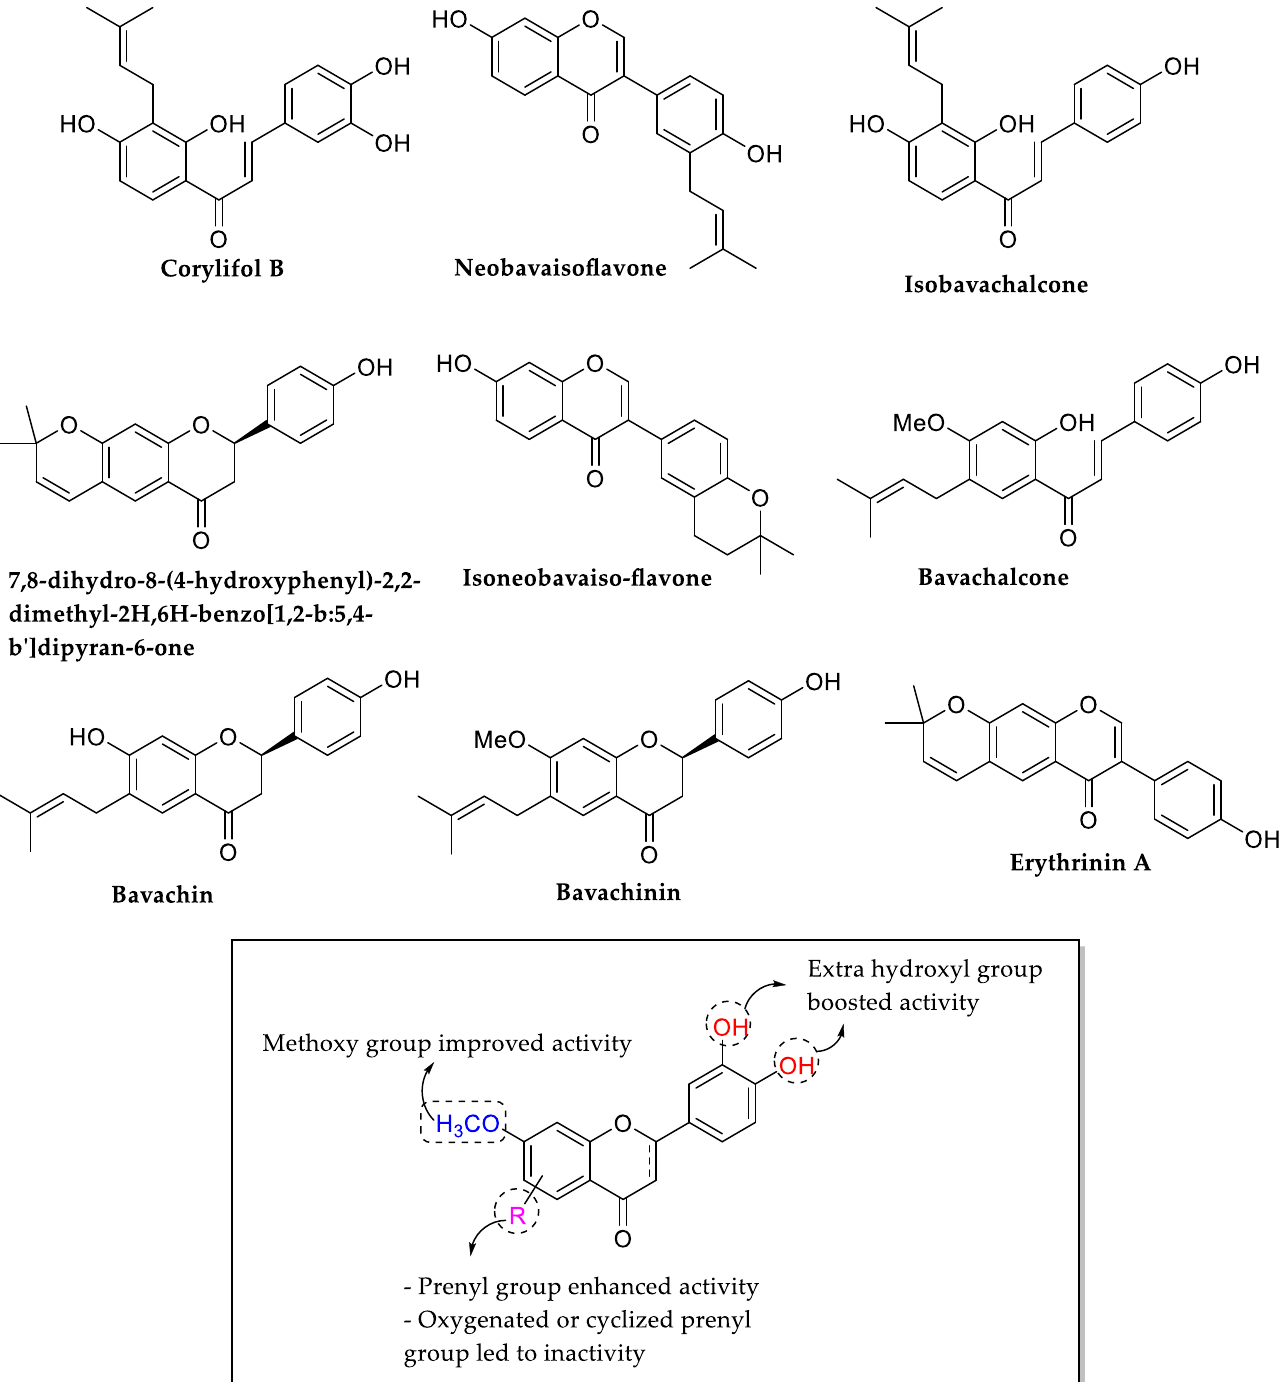
Figure 12. Chemical structures of isolated flavonoids that have excellent inhibition and the sum- mary of important structural features of flavonoids as antibacterial agents isolated from Psoralea corylifolia seeds [78].